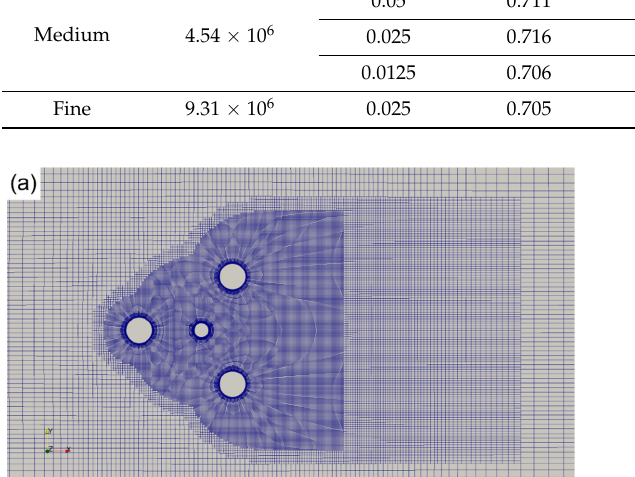
Table 3. Results of mesh and time-step size sensitivity tests for VIM of FOWT platform at α = 0 ◦ and V r = 10.